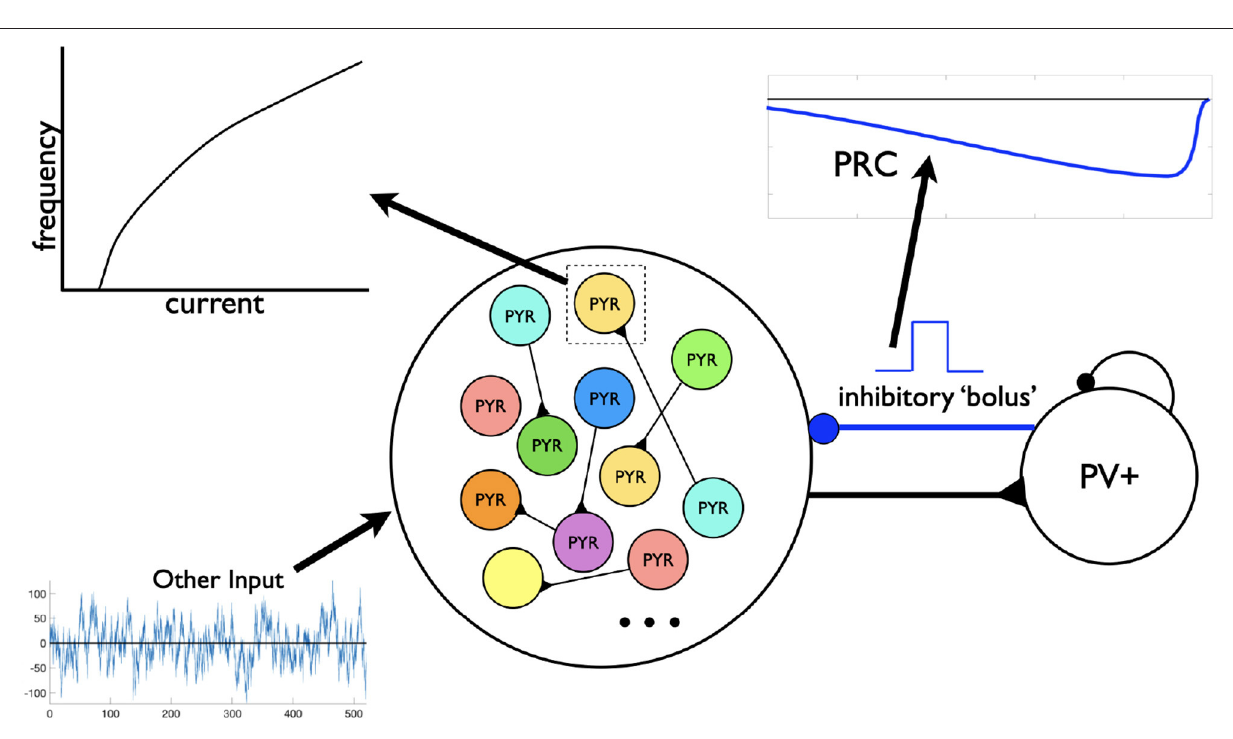
FIGURE 5 | Motivation for the setup in phase response curve (PRC) calculations. Assuming a theta-generating mechanism based on model design, PRCs are generated based on an inhibitory input (“bolus”) coming from the PV+ cell network to an individual PYR cell. Each PYR cell is receiving a noisy drive shown as “Other Input” as well as from other PYR cells. An illustrative f-I curve is shown for an individual PYR cell. An illustration of a computed PRC based on the inhibitory input to a particular PYR cell is also shown. It would be dependent on the particular PYR cell’s model parameter values that dictates its f-I